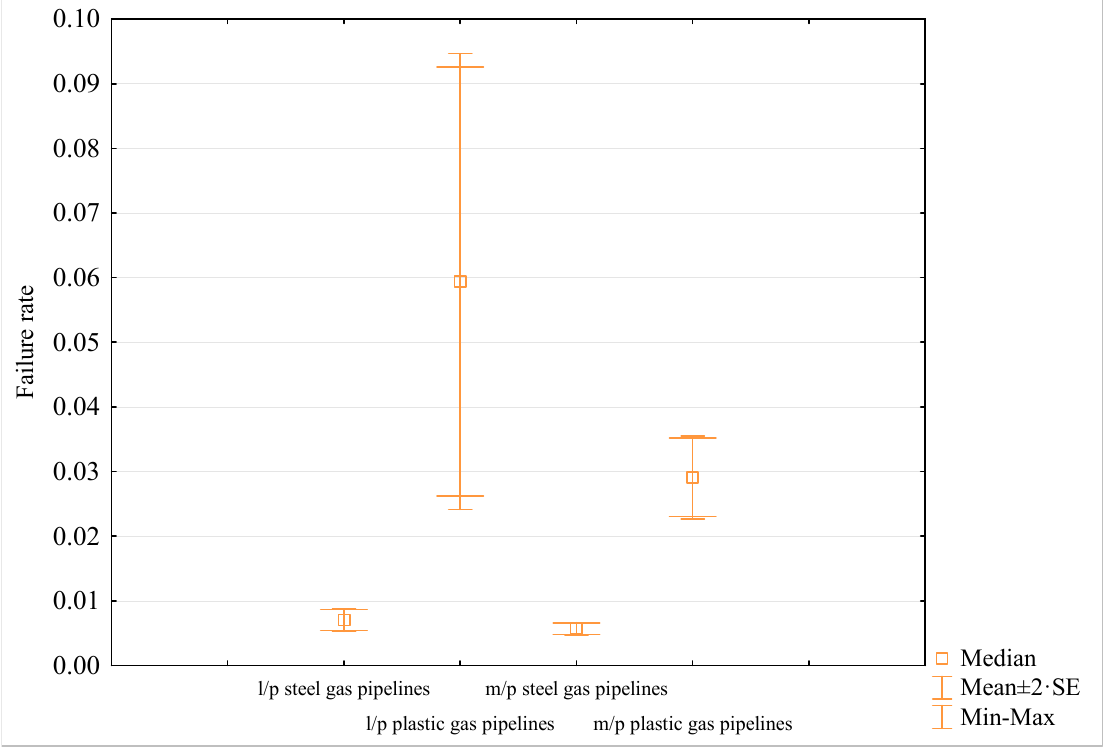
Figure 5. A medium-pressure and low-pressure gas pipeline’s failure rate, per material type. The average value for the failure rate index was λ av = 0.02555 failure/(km · year), assuming F = 1. We used the failure rate index limits indicated in [26–29] as reference thresholds in the absence of a standard value regulating the admissible limits. As the failure rate indices obtained in our case are lower than the reference thresholds, the studied gas-supply network can be considered in a good technical condition. This index has a considerable impact on gas customers’ perception of the service quality, as well as of the company’s trustworthiness and credibility.